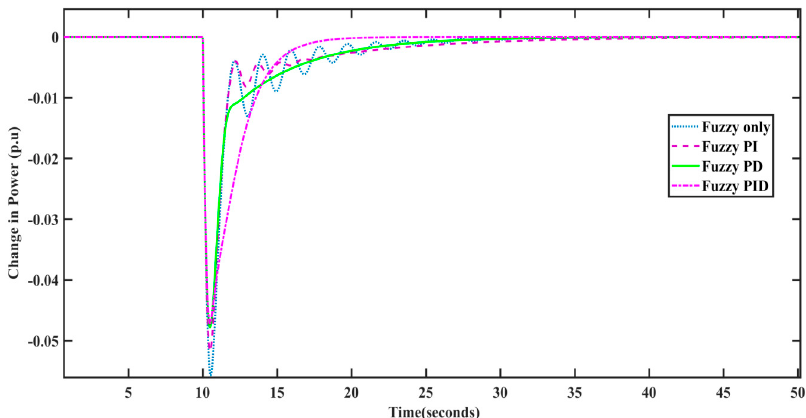
Figure 15. Dynamic response comparison of different control configurations of IHPS frequency change with step input of 10% increase in load.